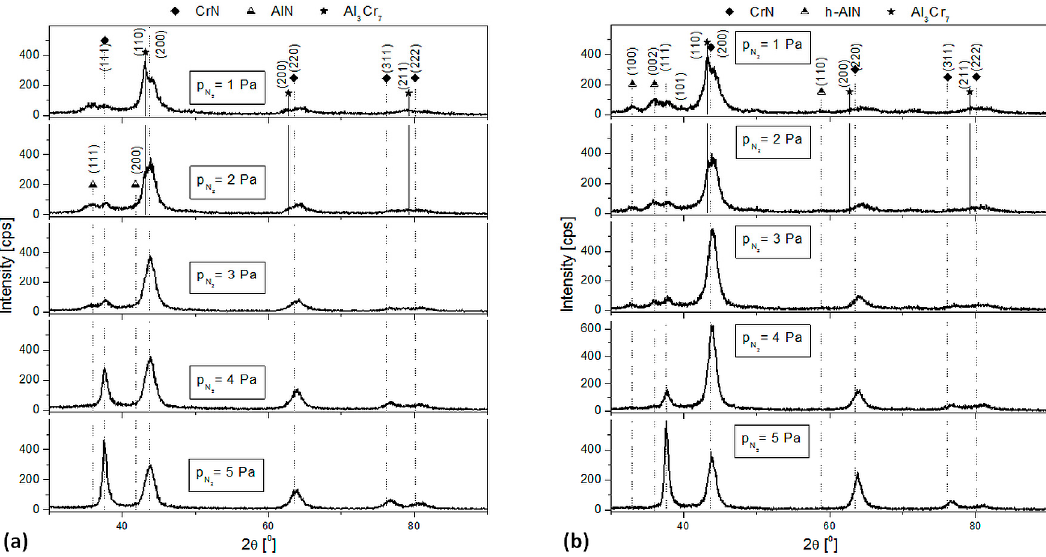
Figure 3. XRD diffraction patterns for AlCrN coatings deposited at negative substrate bias voltage 100 V, various nitrogen pressure and temperatures. ( a ) 350 °C; ( b ) 450 °C.